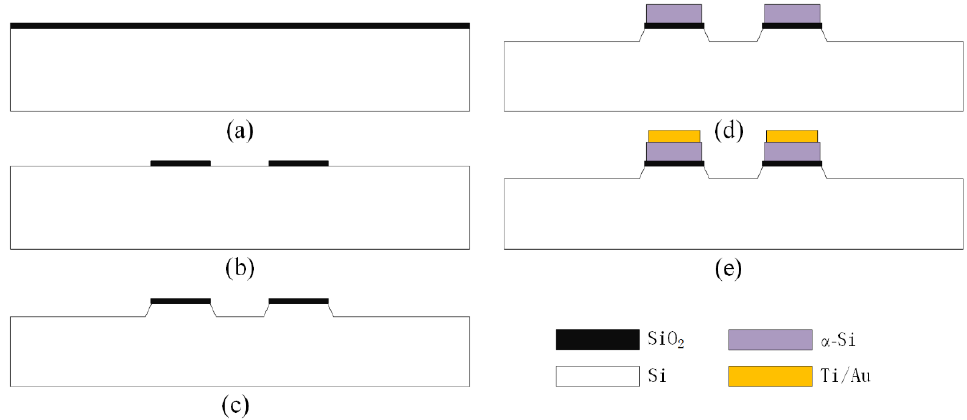
Figure 7. Process flow of the reroute substrate. ( a ) Oxidation to form the hard mask; ( b ) formation of the etching window of the KOH; ( c ) formation of the convex structure with a height of 7 μm; ( d ) deposition of the 1 μm-thick layer of amorphous silicon (α-Si) used for subsequent Au–Si eutectic bonding; ( e ) formation of the composite metal Ti/Au layer used to reroute the tactile sensor.